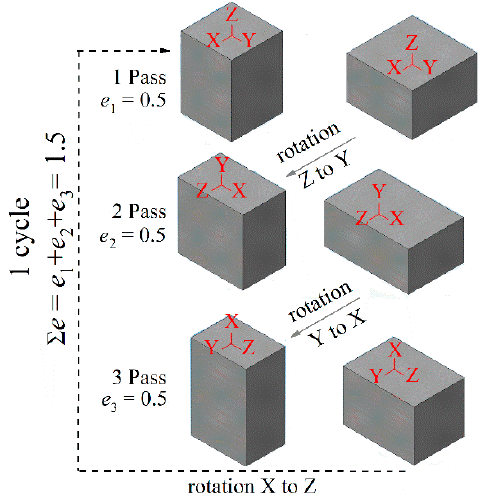
Figure 1. The scheme of the sample rotation during isothermal multidirectional forging (IMF). To produce the sheets, IMF-processed samples were subjected to cold rolling (rolling mill V-3P, GMT, Saint-Petersburg, Russia) with a 50% reduction. The simple thermomechanical treatment without IMF was performed to produce the samples for comparison. Rolling at 200 or 400 °C with a reduction of 88% ( e = 2.1) was used instead of IMF.